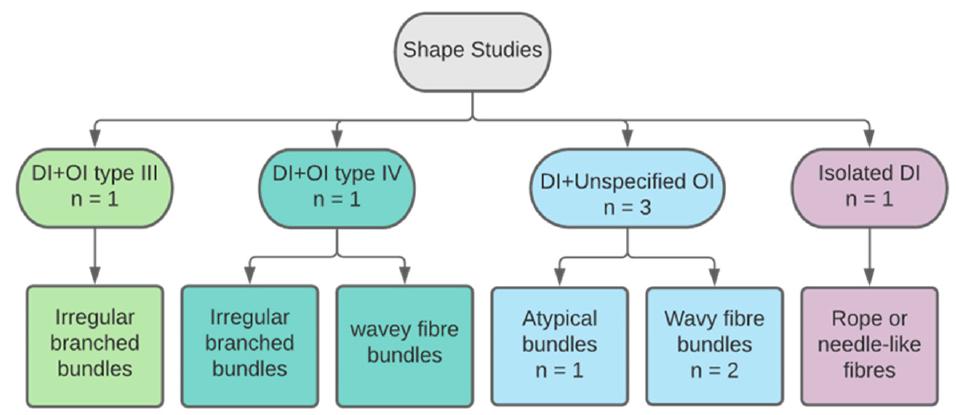
Figure 9. Categorisation of studies reporting on collagen shape by DI and OI types.